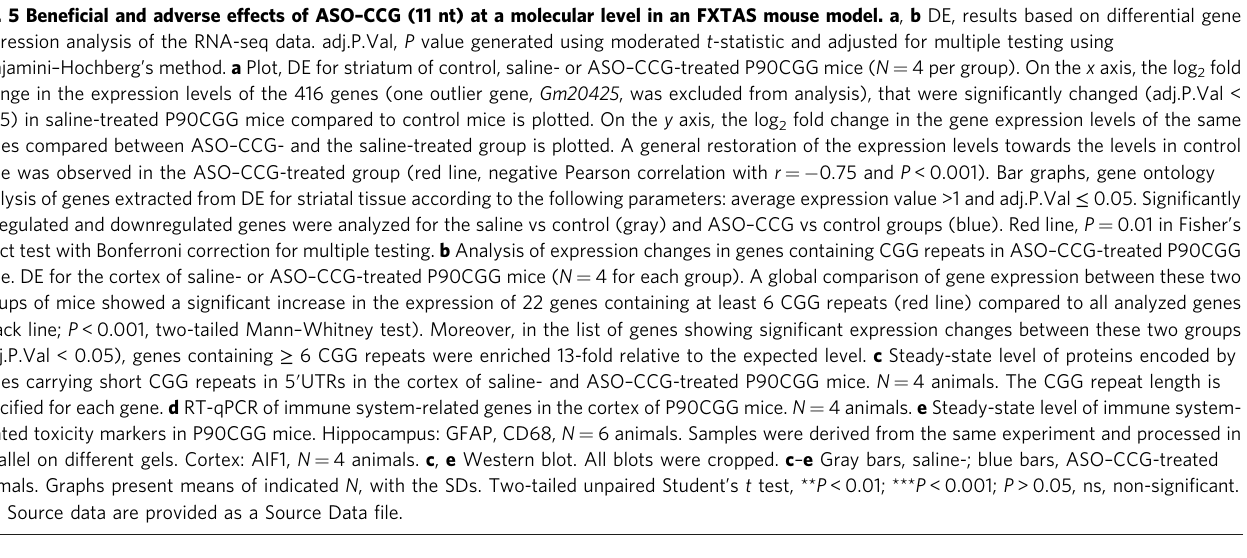
Fig. 5 Bene fi cial and adverse effects of ASO – CCG (11 nt) at a molecular level in an FXTAS mouse model. a , b DE, results based on differential gene expression analysis of the RNA-seq data. adj.P.Val, P value generated using moderated t -statistic and adjusted for multiple testing